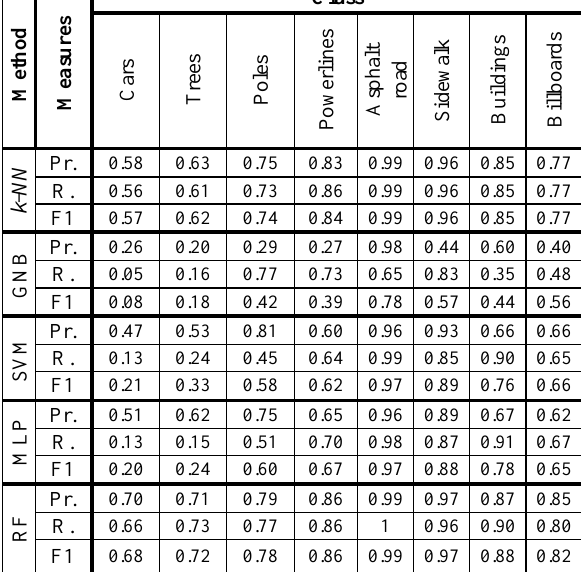
Table 2. Evaluation of the applied classification methods for MTLS point cloud